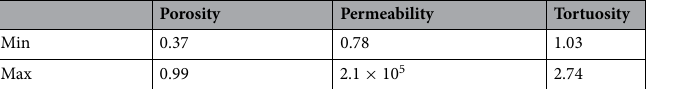
Table 1. The ranges of the porosity, permeability, and tortuosity obtained for the ensemble of 100,000 samples of the systems generated within the fluid flow simulation procedure.